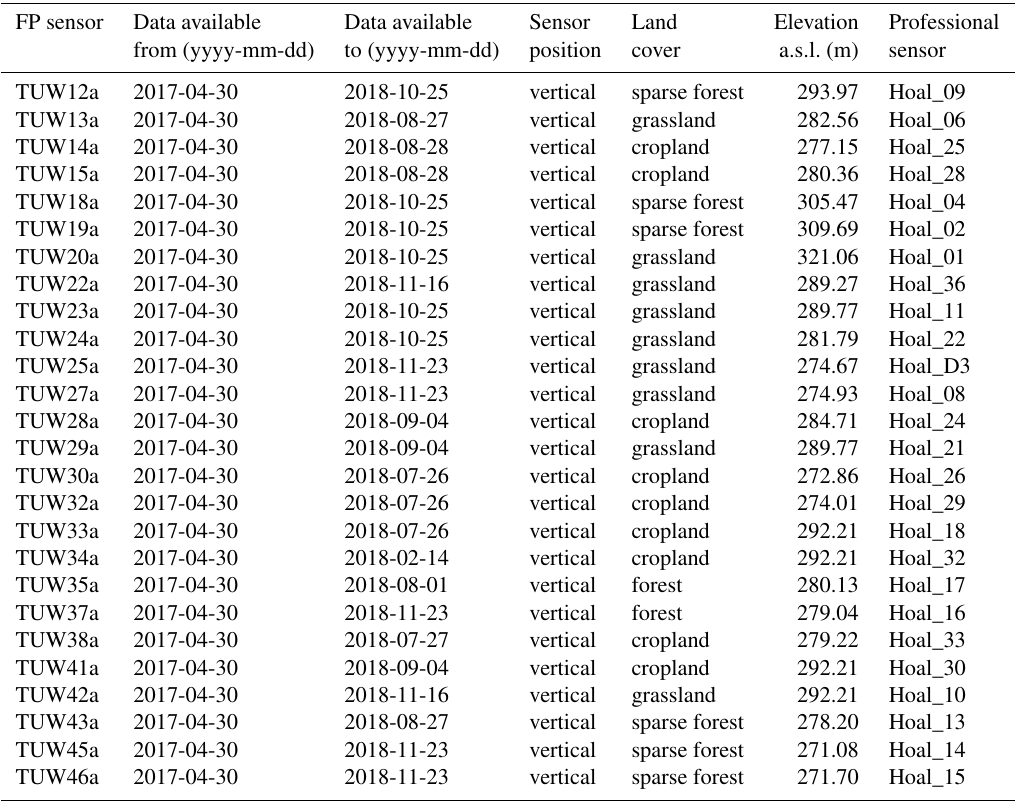
Table A1. Available FP sensors used for temporal stability analysis.